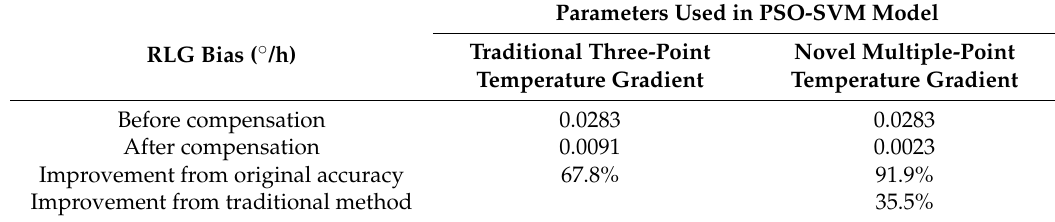
Figure 8. RLG bias compensation model utilizing novel multiple-point temperature gradient algorithm with ( a ) random temperature variation rates, and ( b ) enlarged error curve. Table 5. RLG bias compensation effect of PSO-SVM model using different temperature gradient algorithms in random temperature experiment.